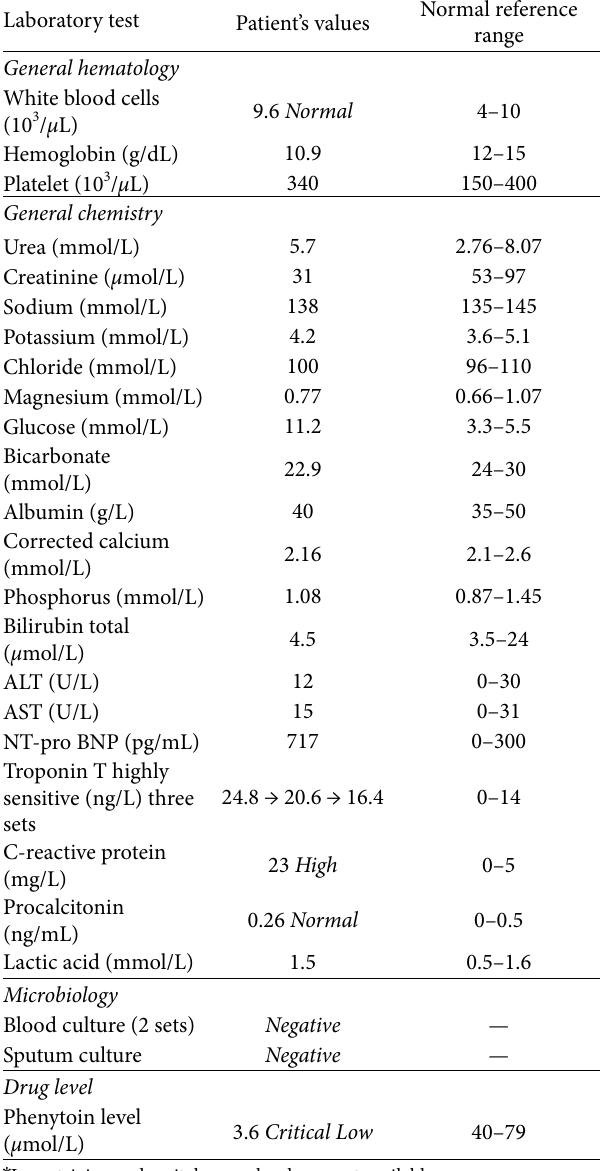
Table 1: Laboratory tests ∗ .